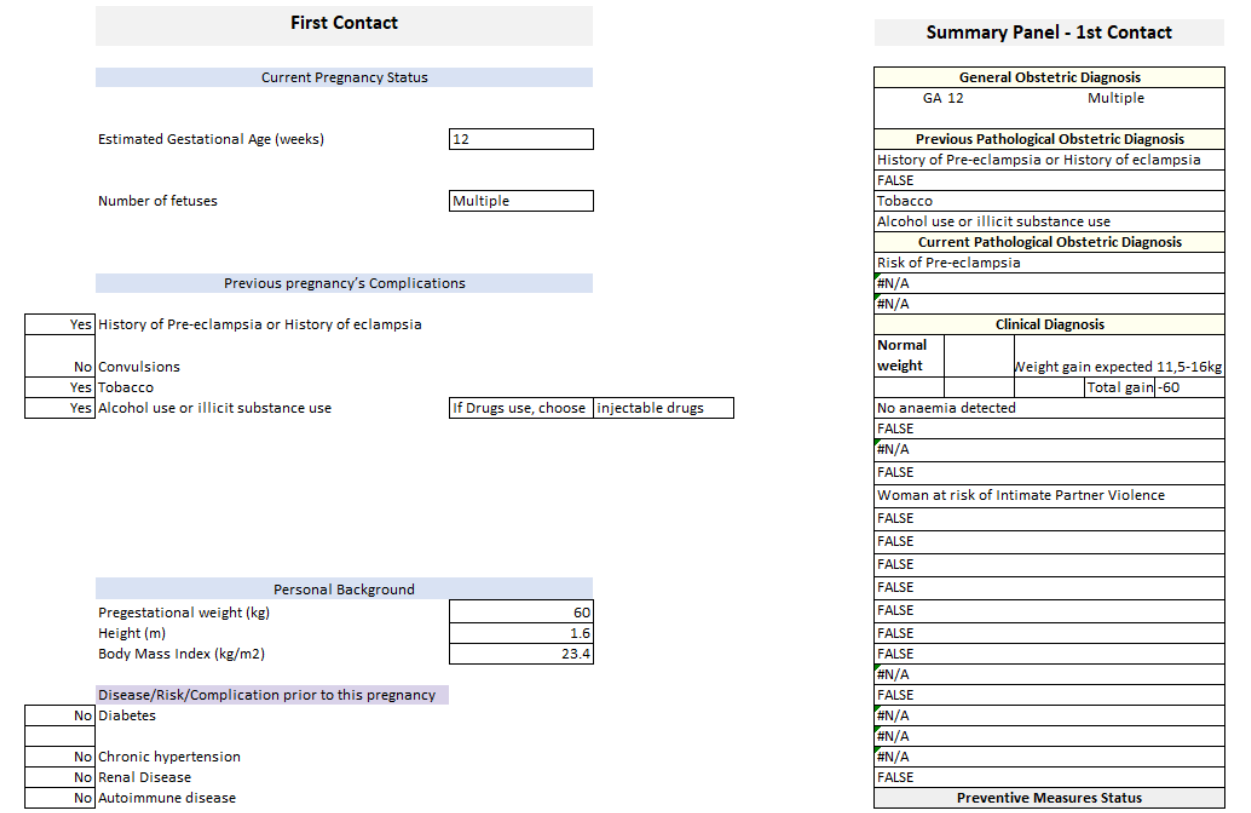
Figure 4. Excel testing